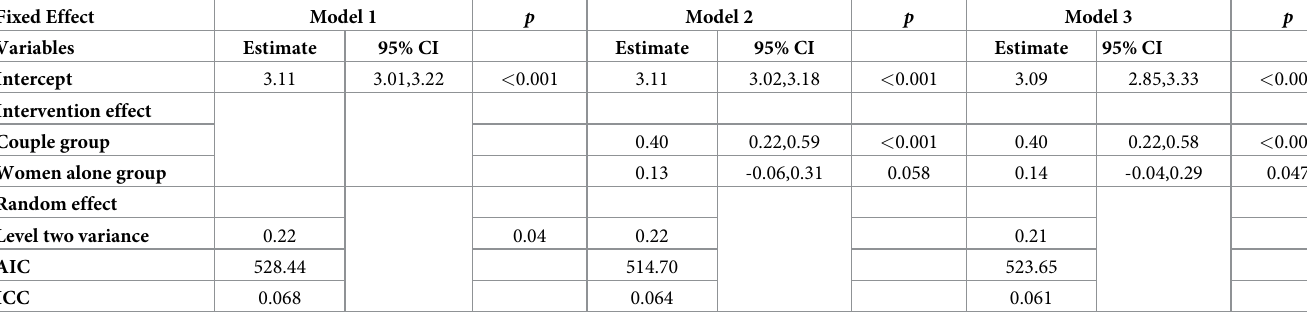
Table 5. Linear Mixed-Effects Model predicting birth weight of newborns in Illu Aba Bor, Zone Southwest Ethiopia, 2019/20.